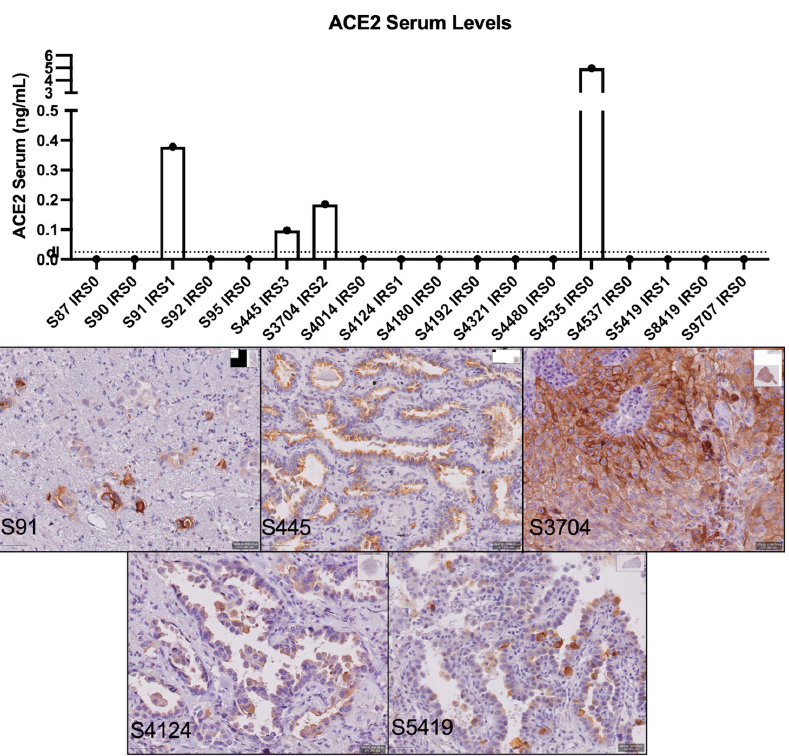
Figure 3. sACE2 levels and ACE2+ tumor samples.